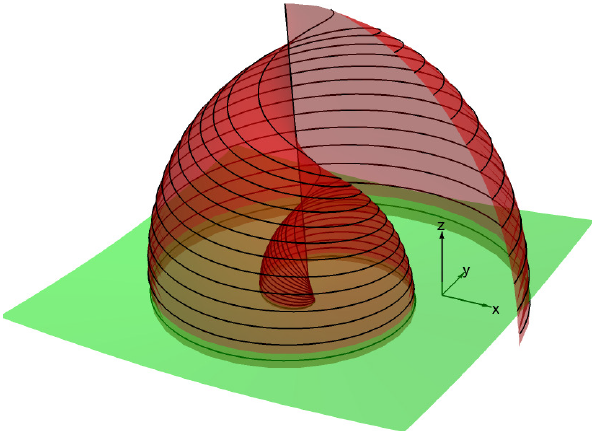
Figure 4. Magnetic field lines (black curves) in the Parker spiral model for different latitude angles θ from the rotation axis. Curves are defined as the intersection of the surfaces of the Euler potentials, α E = const . and β E = const . , as presented by Webb et al. (2010). Note that the spiral magnetic field lines are constructed with the ra- dial component from the Sun and the azimuthal component around the rotation axis and do not contain the polar component (in the direction toward the rotation axis and perpendicular to the radial di- rection). The spiral field lines have an axial component along the rotation axis, but this is due to the radial component of the spiral field line (in the sense of being away from the rotation